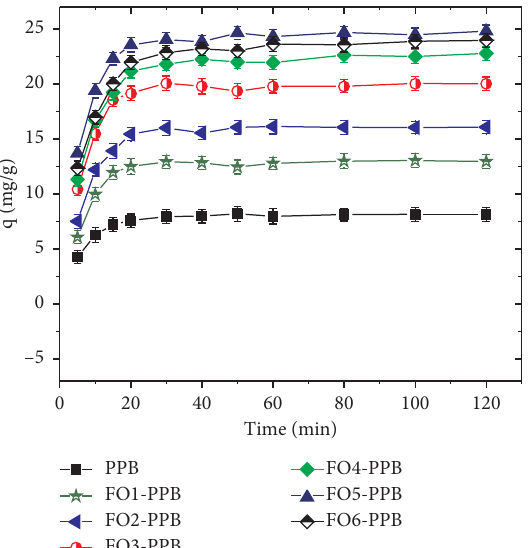
Figure 5: The effects of various impregnation ratios between Fe and PPB on the adsorption capacity of RR21. Conditional parameters: initial RP21 concentration: 50mg/L; pH: 3; adsorbent dose: 2g/L; temperature: 25 ± 2 °